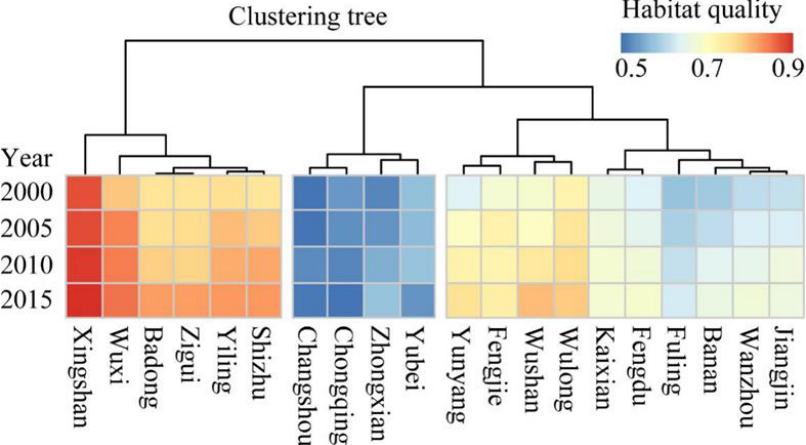
Figure 6. Heat map of correlation matrix and hierarchical clustering for 20 counties in the TGR area according to habitat quality.